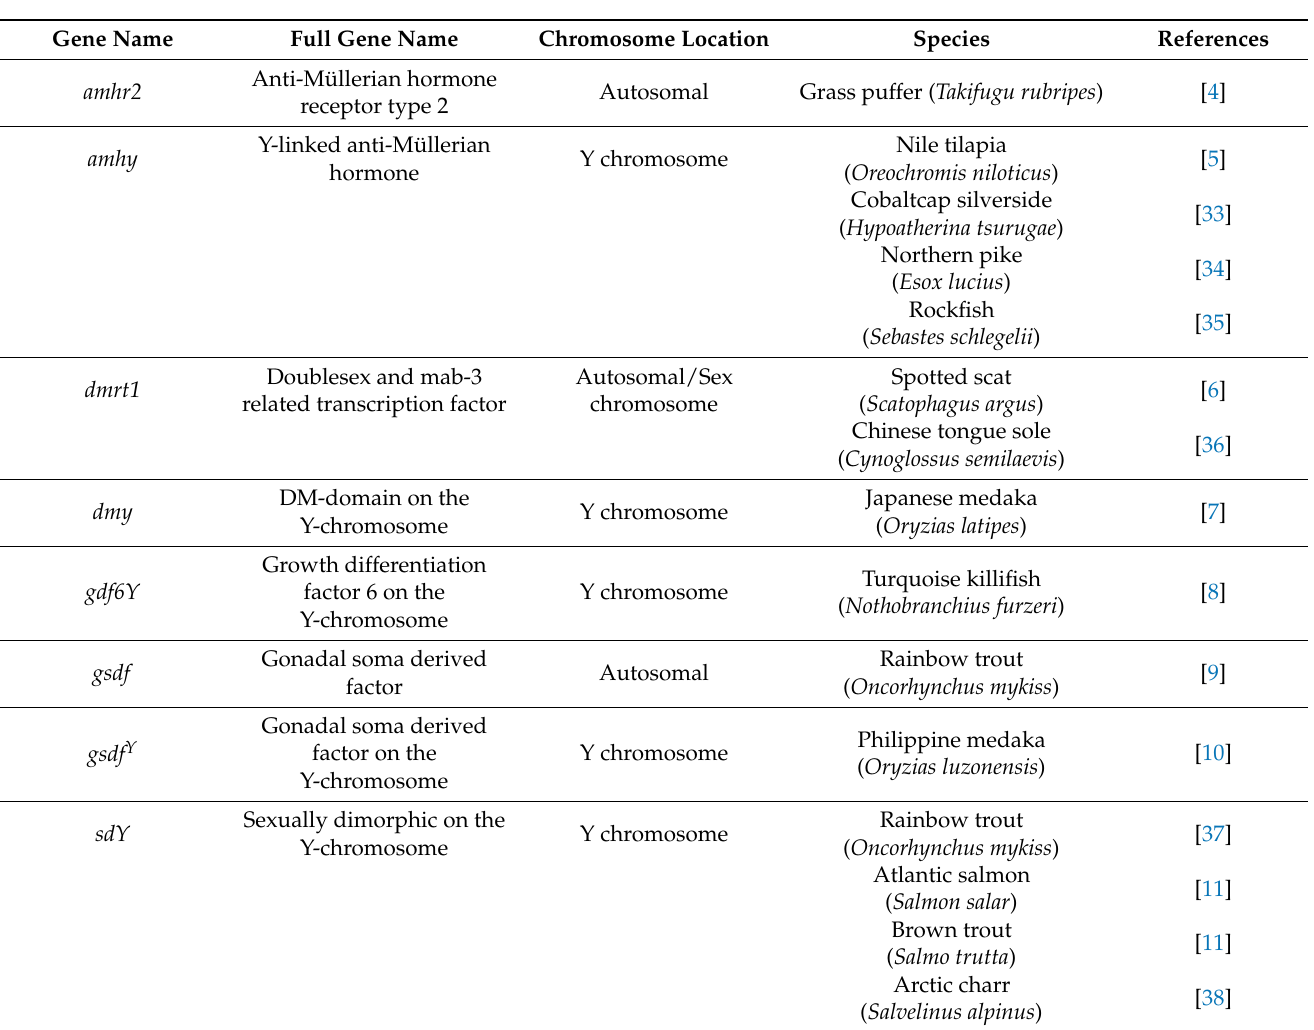
Table 1. List of sex-determining genes in teleost